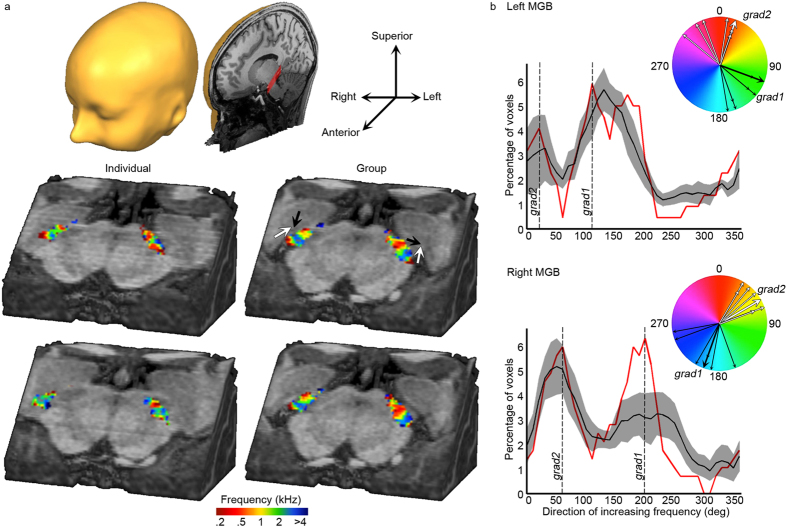
Group and individual tonotopy in the MGB.(a) Maps of frequency preference (tonotopic maps) in two individual subjects (first column; see Supplementary Fig. 4 for all individual maps) and in the group (second column). A cube of brainstem based on a high-resolution anatomical image of an individual subject is shown from the front-left, and a cut through it is made at a 45° angle such that the MGB is visible (indicated as the red shaded area on the cut in the left upper corner inset). The maps are superimposed on this image. For the right column, from top to bottom superior to inferior cuts through the MGB are displayed. (b) Distribution of direction of increasing frequency, calculated on individual voxels in slices oriented as in (a). Red and black lines show the direction of increasing frequency for the group tonotopy map and the average of distributions resulting from individual maps, respectively (±s.e.m. in grey). Black and white arrows in the coloured circles represent the first and second peak of red curve (thick arrow, representing the two main directions of increasing frequency in the group tonotopy map), and two peaks of each individual’s distribution (thin arrows, representing the main directions of increasing frequency in the individual tonotopy maps; subjects with the same peak value are displayed as additional arrowheads).